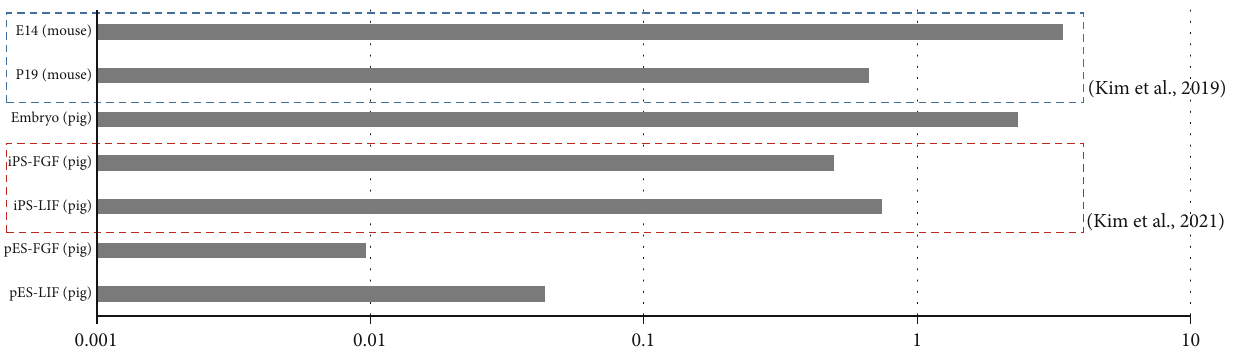
Figure 5: Comparison of the distal/proximal enhancer activity rate in pluripotent cells of mouse or pig. The activity of OCT4 distal and proximal enhancers was compared in various pluripotent cells. Cells with a naïve pluripotent state (mouse E14 ESCs, porcine embryo) had a value greater than 1, which indicates higher activity of the distal enhancer than the proximal enhancer. On the other hand, cells known as the primed pluripotent state (mouse P19 ECs, FGF- or LIF-dependent piPSCs) had a value less than 1, which indicated that the proximal enhancer has higher activity than the distal enhancer. E14 mouse embryonic stem cells, P19 mouse embryonic carcinoma, porcine embryo, FGF- or LIF-dependent porcine induced pluripotent stem cells, and porcine embryonic stem cells with FGF- or LIF- supplemented culture media. Mouse E14 and P19 cells were analyzed by using luciferase assay in (Kim et al., 2019), and porcine-induced pluripotent stem cells were analyzed in (Kim et al., 2021).